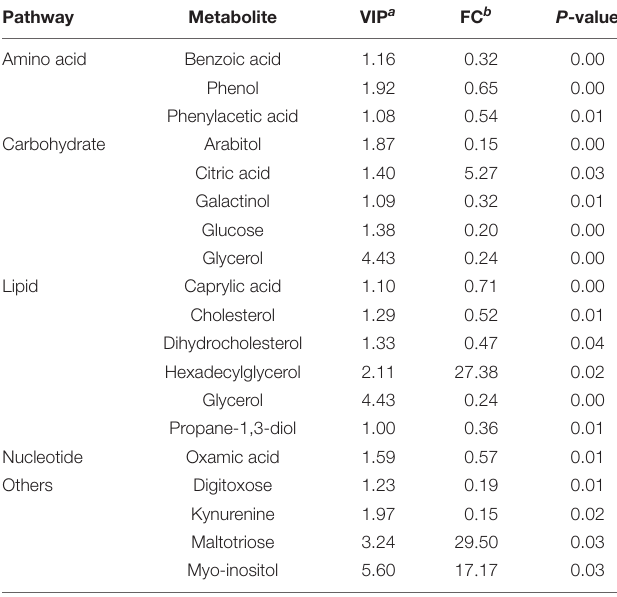
TABLE 3 | The colonic metabolites that differed between suckling group and weaning group.